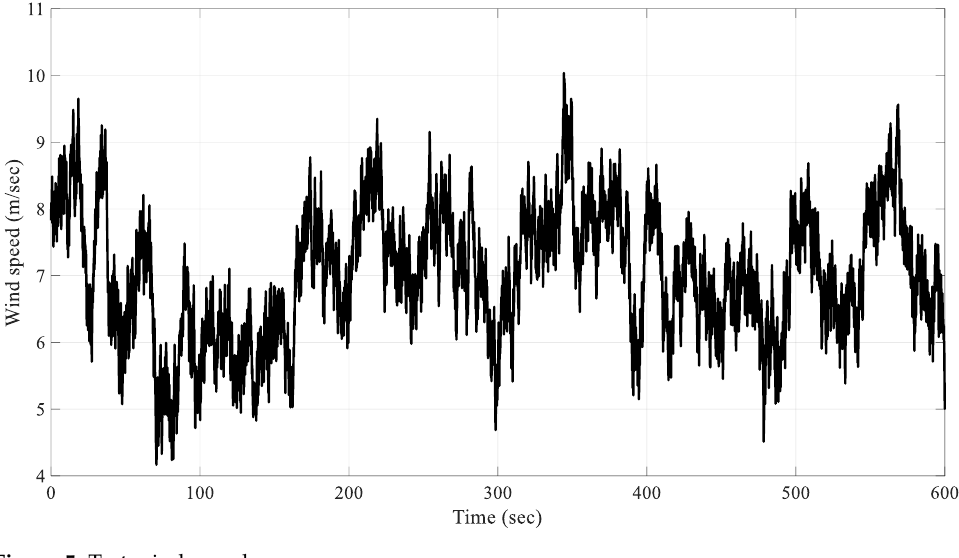
Figure 5. Test wind